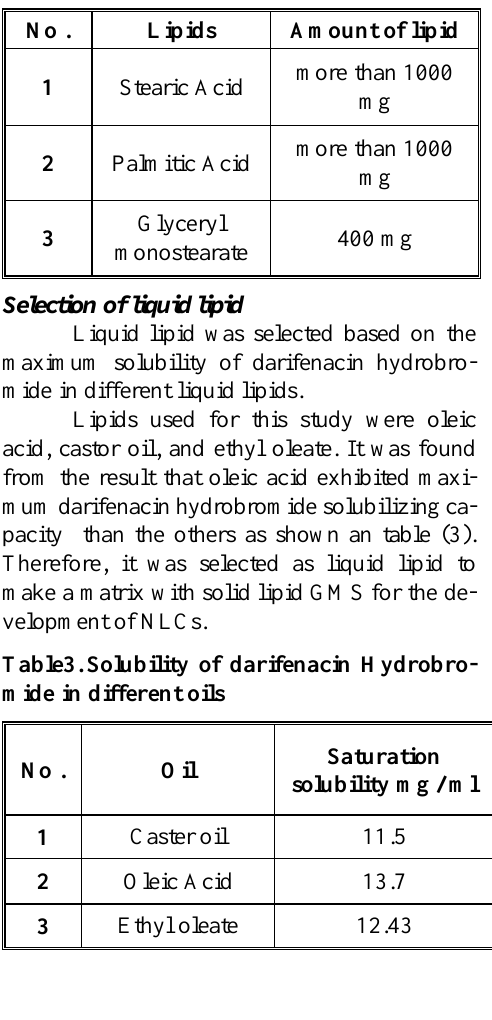
Table2. Amount of solid lipid required to sol-